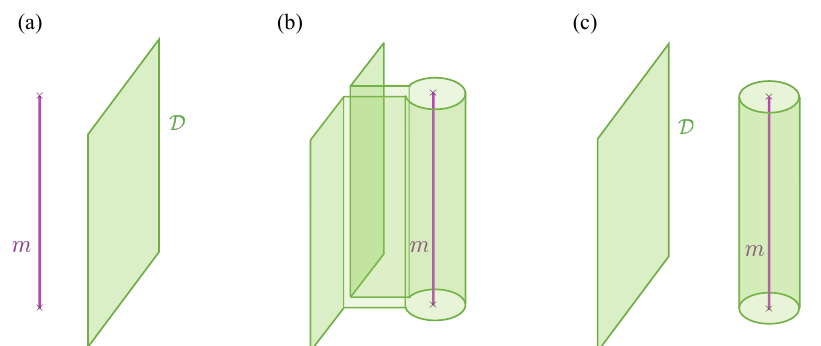
Figure 24: The process of a magnetic flux passing through a codimension-1 invertible twist string in a ( 2 + 1 ) D theory. The figure shows the (2 + 1)D spacetime. In this figure, the magnetic flux m is a line operator (purple line) extended in the vertical direction. Meanwhile, the codimension-1 twist string defect is described as a 2D D surface in the spacetime. As a magnetic flux passes through the defect, the defect will wrap around it as shown in (b). One can shrink the wrapping cylinder of the defect so that the magnetic flux is dressed by a dimensionally-reduced twist defect as shown in (c). Note that the whole process leaves the correlation function invariant, due to bordism invariance of the partition function of the (1 + 1)D SPT phase that corresponds to the defect D